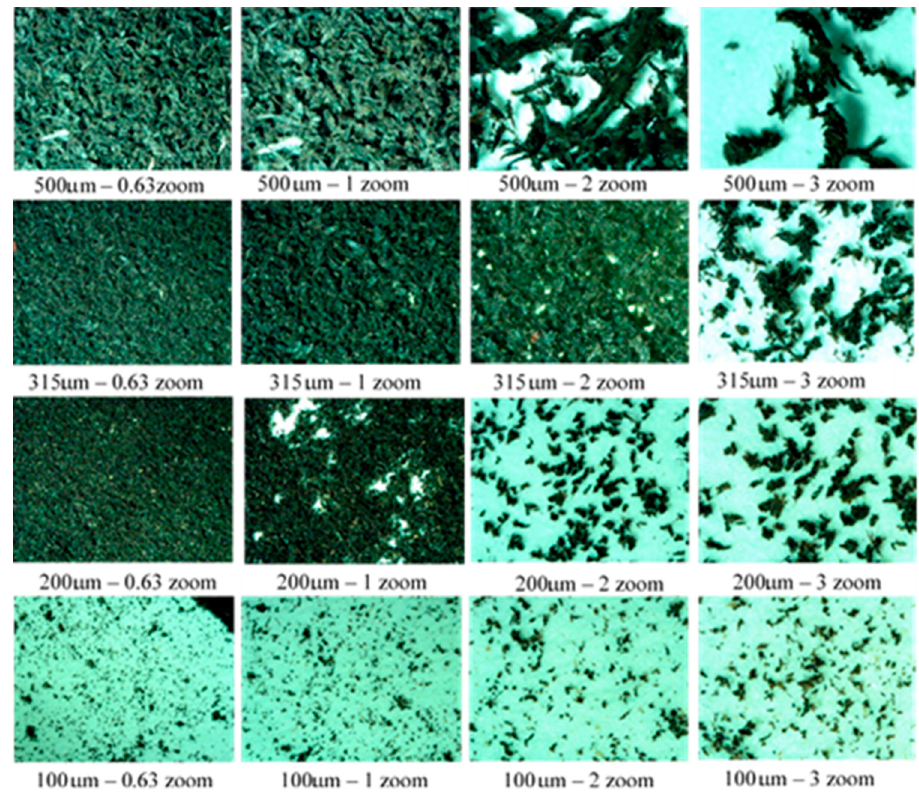
Figure 4. Ebony dust particles and their shape.